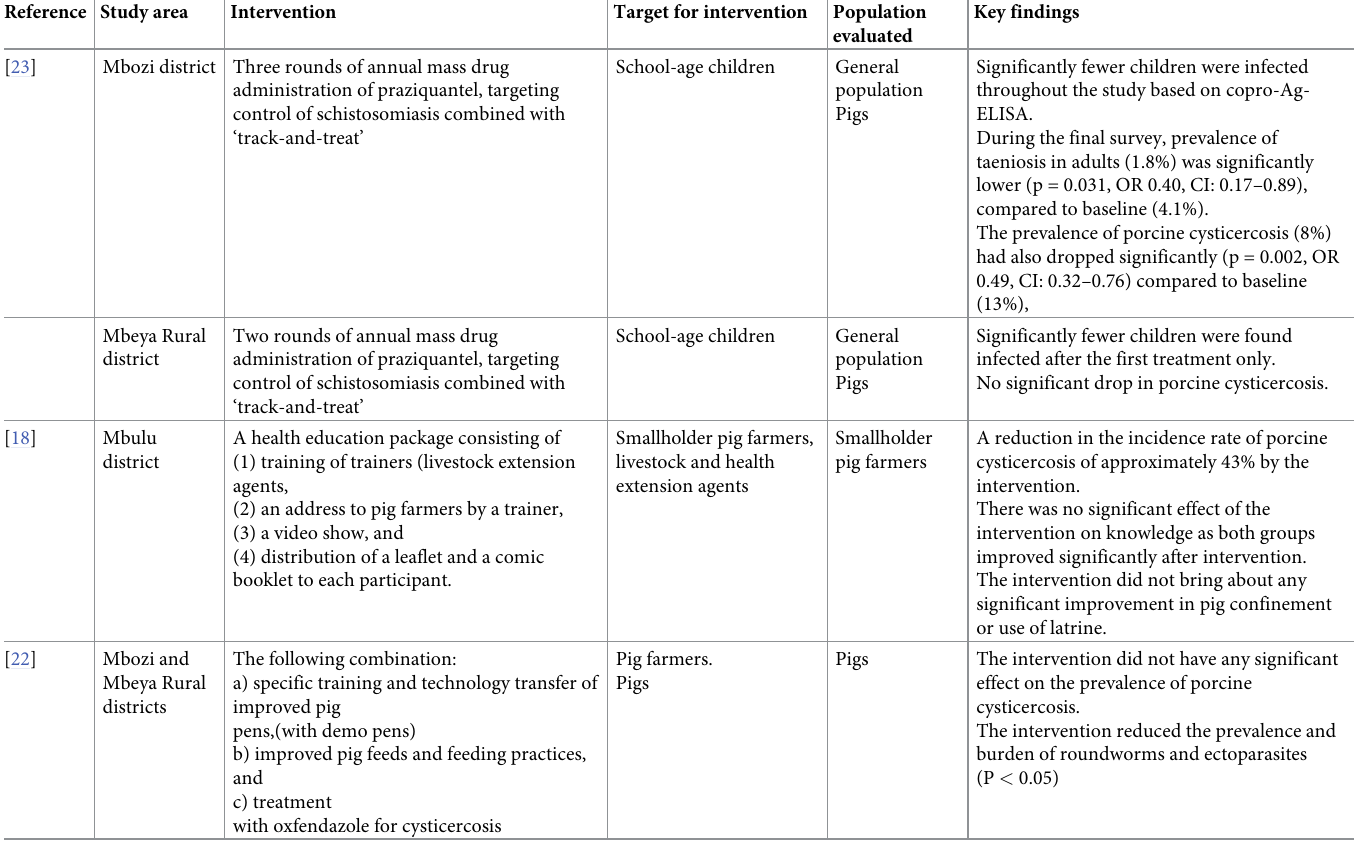
Table 6. Effectiveness of Taenia solium control strategies evaluated in Tanzania,